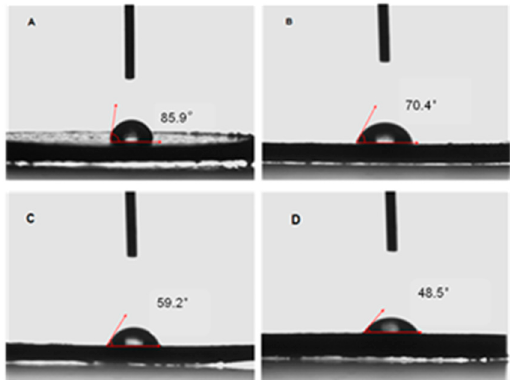
Figure 7. Water contact angle of polyethylene ( A , PE) from run 1 in Table 1 ethylene/ N -acetyl- O -(but-3-enyl)- L -tyrosine ethyl ester copolymers; ( B ) comonomer insertion ratio of 1.16 mol % from run 2 in Table 1; ( C ) comonomer insertion ratio of 2.24 mol % from run 3 in Table 1; ( D ) comonomer insertion ratio of 2.65 mol % from run 4 in Table 1).